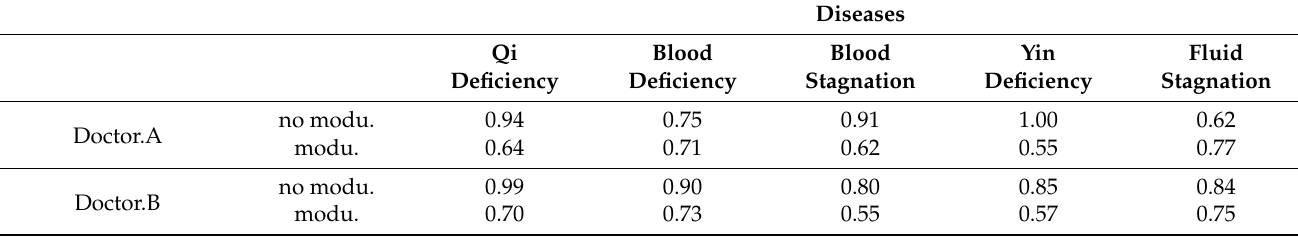
Table 5. Mean absolute error between the correct value (using the value assigned by each Kampo doctor) and the value estimated by support vector regression for each disease using data with no modulation (no modu.) and modulation